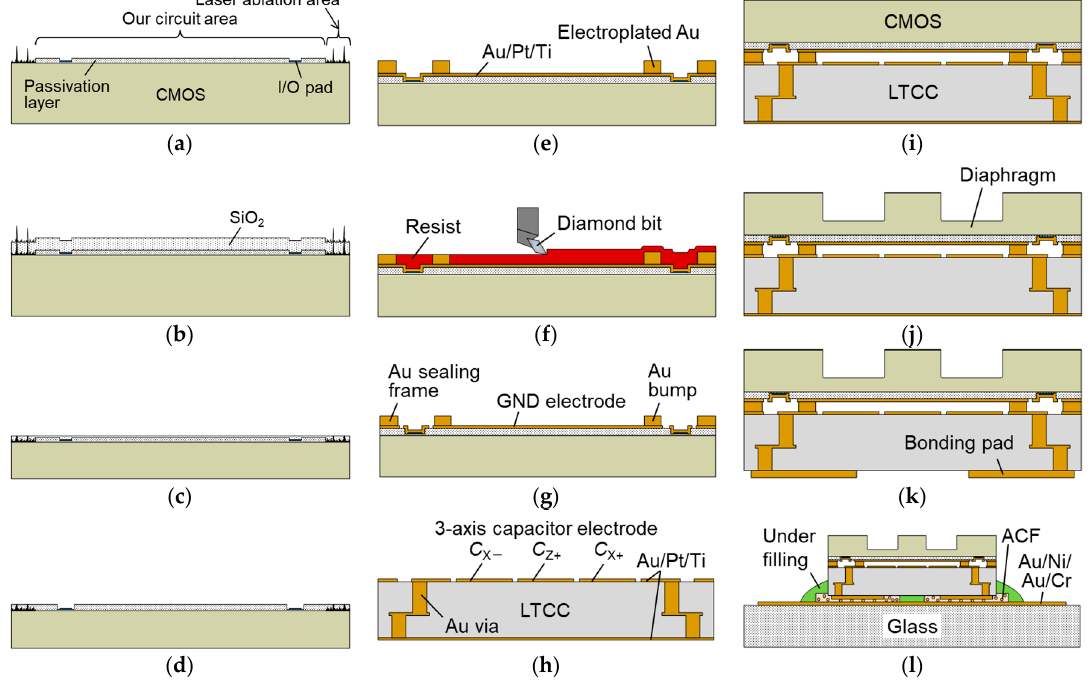
Figure 6. Fabrication process of the 3-axis integrated tactile sensor: ( a ) Received CMOS substrate; ( b ) Thick SiO 2 film deposition; ( c ) Planarization and back grinding; ( d ) Pad opening; ( e ) Au electroplating; ( f ) Planarization of Au bumps and an Au sealing frame; ( g ) Formation of a ground (GND) electrode and rewiring; ( h ) Formation of 3-axis capacitor electrodes and rewiring; ( i ) Au-Au thermo-compression bonding; ( j ) Formation of a diaphragm; ( k ) Formation of bonding pads; ( l ) Surface mounting on a glass substrate with interconnections by an anisotropic conductive film (ACF).